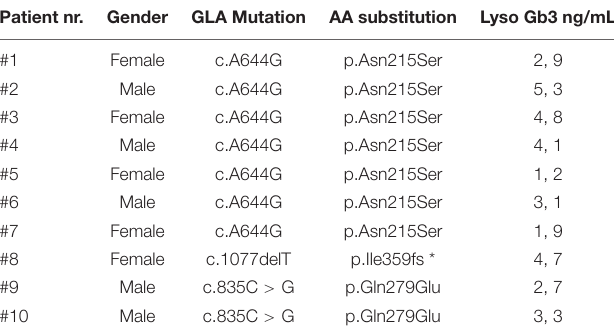
TABLE 1 | Genetic characterization and plasma levels of Lyso Gb3 assessed at baseline (T 0 ) in our cohort of Fabry